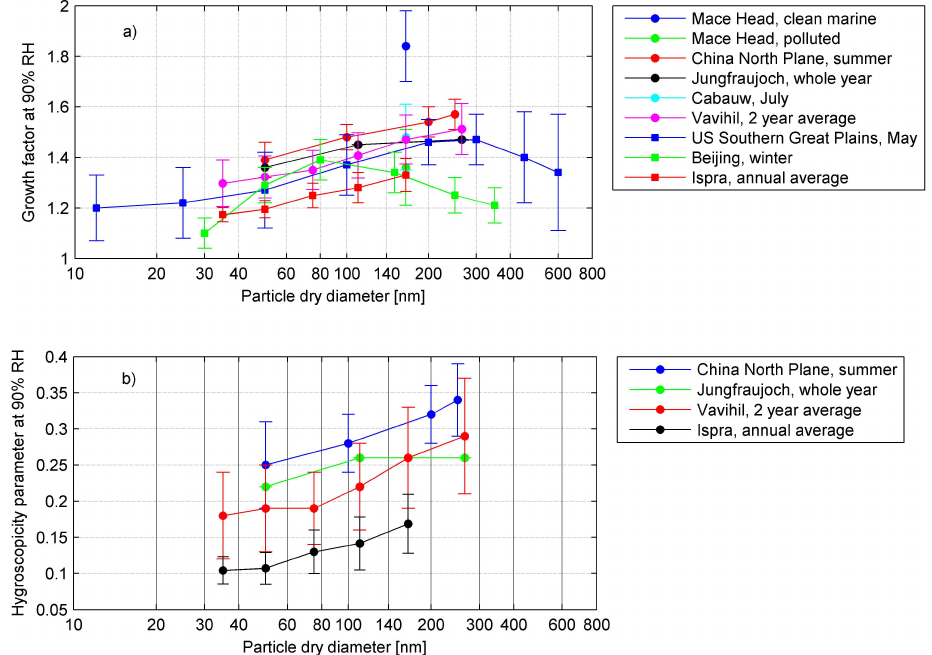
Fig. 4. Average and standard deviation of hygroscopic growth factor GF(RH) (a) and hygroscopicity parameter (b) at 90% RH observed at various sites across the world (see references in Sect.